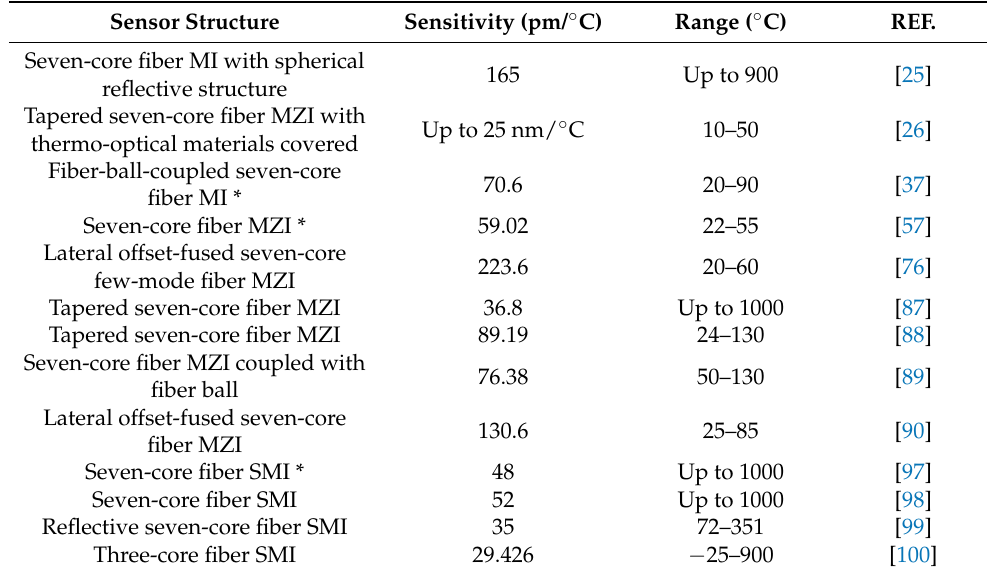
Table 3. Comparison of MCF interferometer-based temperature sensors.